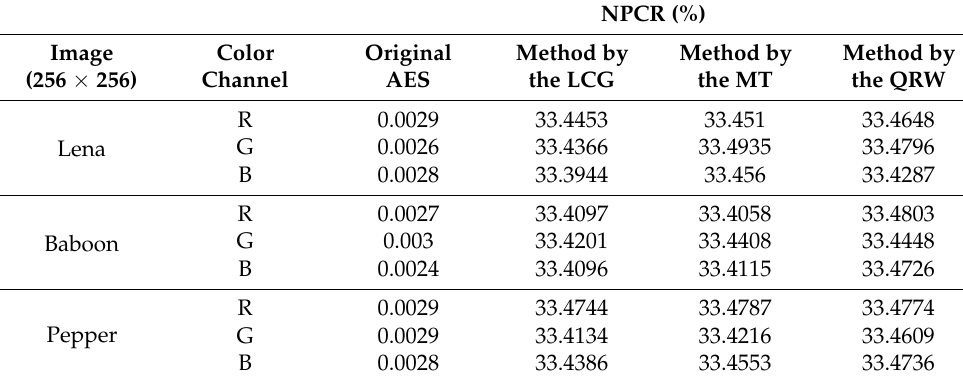
Table 8. UACI result of the original AES and the proposed